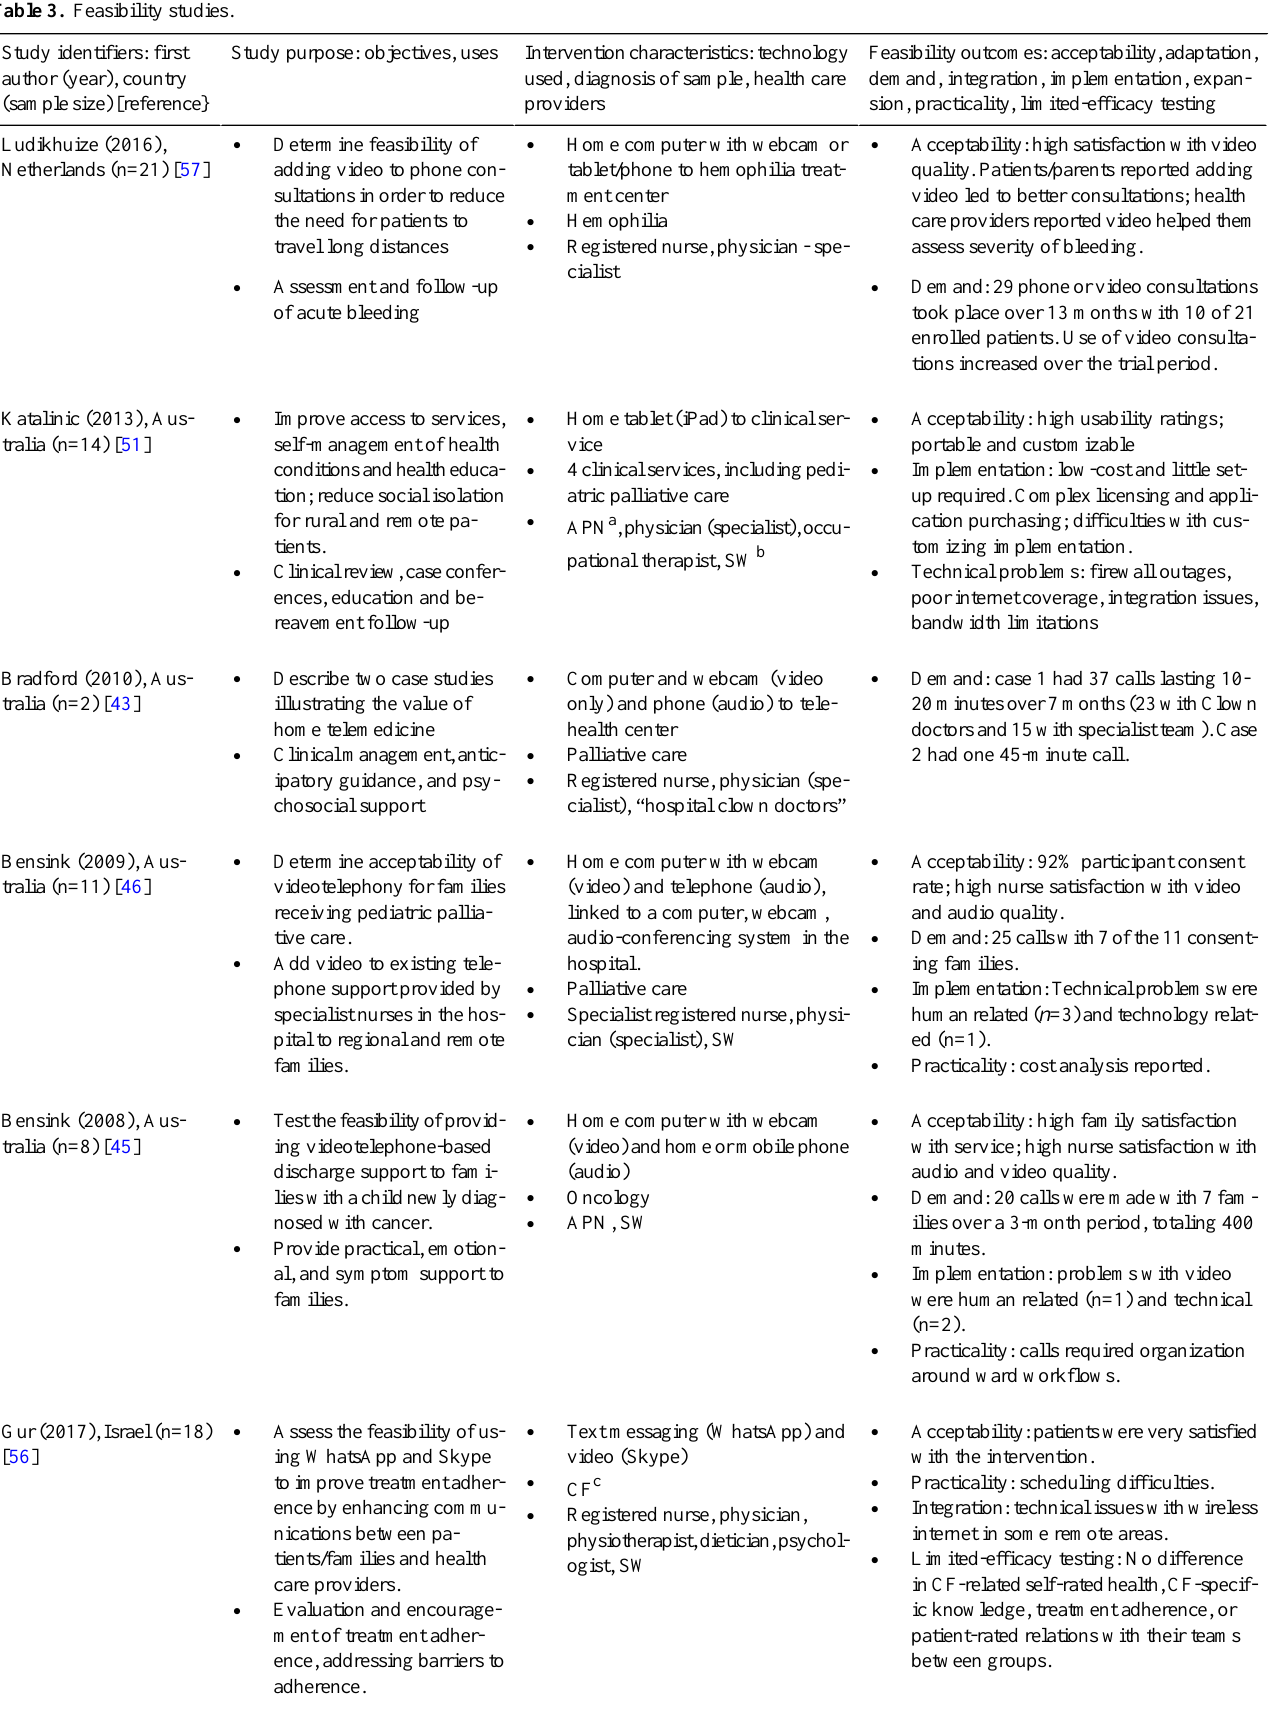
Table 3. Feasibility studies.